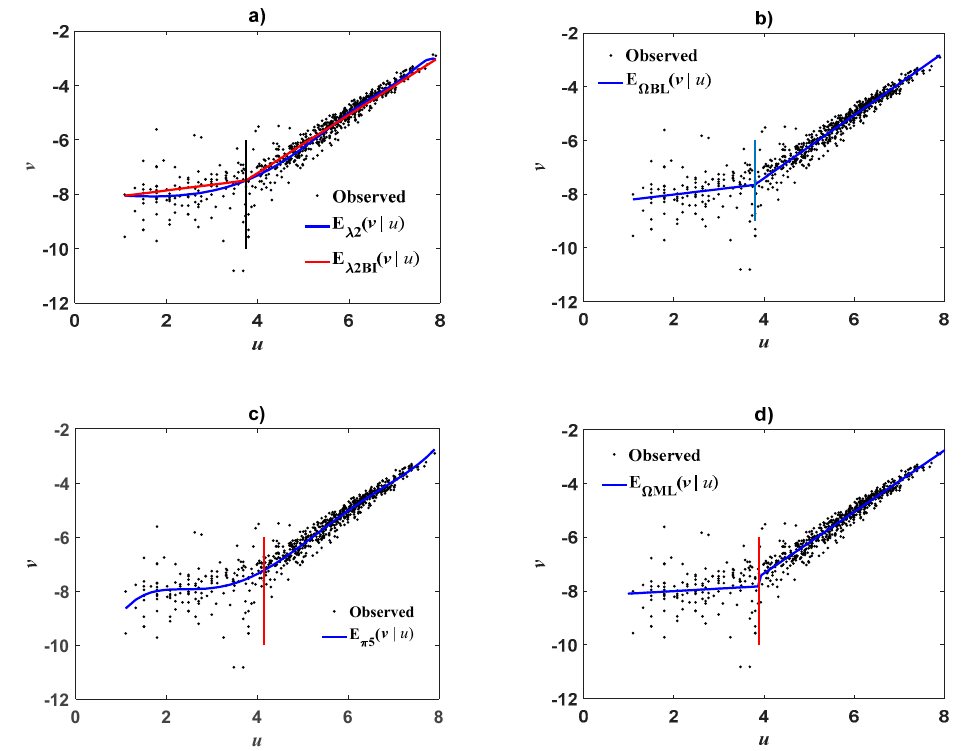
Figure9. MCAprotocolsfittedingeometricalspaceforthe Zosteramarina dataset. Panel( a )dispersionof Figure 9. MCA protocols fitted in geometrical space for the Zostera marina data set. Panel ( a ) response v about mean functions E λ 2 ( v | u ) . The break point signposted by vertical segment is determined dispersion of response 𝑣 about mean functions 𝐸 (cid:3090)(cid:2870) (𝑣|𝑢). The break point signposted by vertical by the interpolation lines criterion presented in Appendix A. Panel ( b ) shows corresponding spreading segment is determined by the interpolation lines criterion presented in Appendix A. Panel ( b ) shows about E Ω BL ( v | u ) . Panel ( c ) shows deviations of v values around polynomial mean response E π 5 ( v | u ) . corresponding spreading about 𝐸 (cid:3078)(cid:3003)(cid:3013) (𝑣|𝑢). Panel ( c ) shows deviations of 𝑣 values around Panel ( d ) is for v spread about E ML ( v | u ) . Plots suggest consistency of MCA fits in all polynomial mean response 𝐸 (cid:3095)(cid:2873) (𝑣|𝑢) . Panel ( d ) is for 𝑣 spread about 𝐸 (cid:3014)(cid:3013) (𝑣|𝑢) . Plots suggest consistency of MCA fits in all cases.